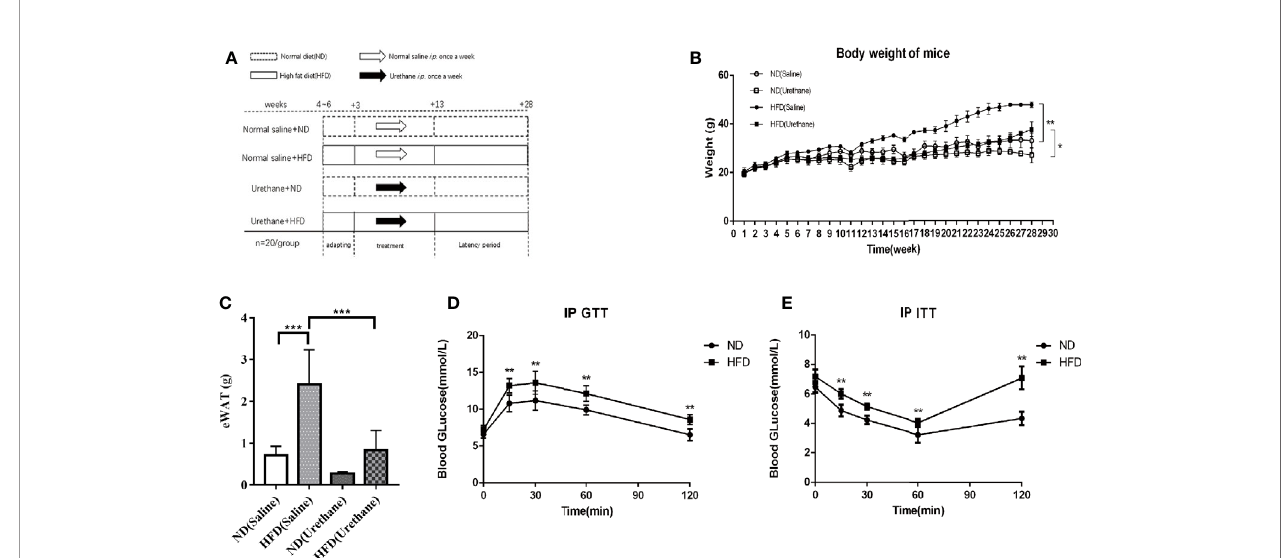
FIGURE 1 | Differences in body weight, intraperitoneal glucose tolerance test (IP GTT) and insulin tolerance test (IP ITT) data among study groups. (A) Schematic diagram of the experimental design for multiple urethane injections induced lung carcinogenesis model in C57BL/6J mice. (B) Body weights of mice measured once a week. Dots indicate the weight mean per group. n=12-15 mice/group. (C) Epididymal WAT (eWAT) mass (n=4-5 mice/group). (D) For IP GTT, mice were made to fast overnight and injected with glucose (2g/kg BW) intraperitoneally in the morning. Blood glucose levels were assessed using tail vein blood samples taken at baseline, 15, 30, 60, and 120 min after injection. n=10 mice/group (E) The IP ITT was performed in mice that were made to fast followed by intraperitoneal injection of insulin (0.75U/kg BW) in 0.9% NaCl. Blood glucose levels were assessed using tail vein blood samples taken at baseline, 15, 30, 60, and 120 min after injection. n=10 mice/group. *P < 0.05, **P < 0.01, ***P <